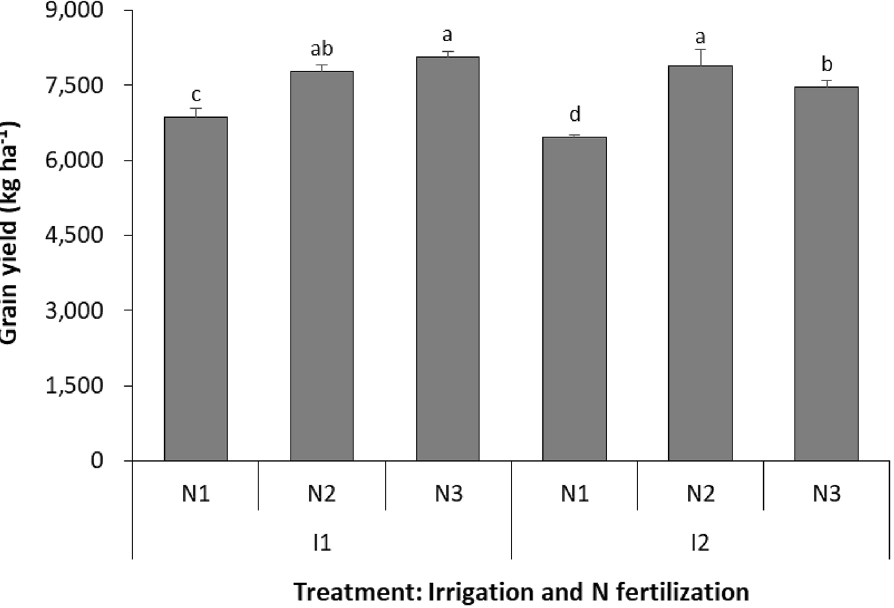
Figure 2. Grain yield of spring wheat with two irrigation quotas and three N fertilizer rates across 2016–2018. I1 and I2 represent irrigation amount at 192 and 240 mm, respectively. N1, N2 and N3 represent an N fertilizer rate of 135, 180, and 225 kg N ha −1 , respectively. Different letters indicate significant differences ( P < 0.05) among treatments and the smaller bars are standard error of means (n = 9).